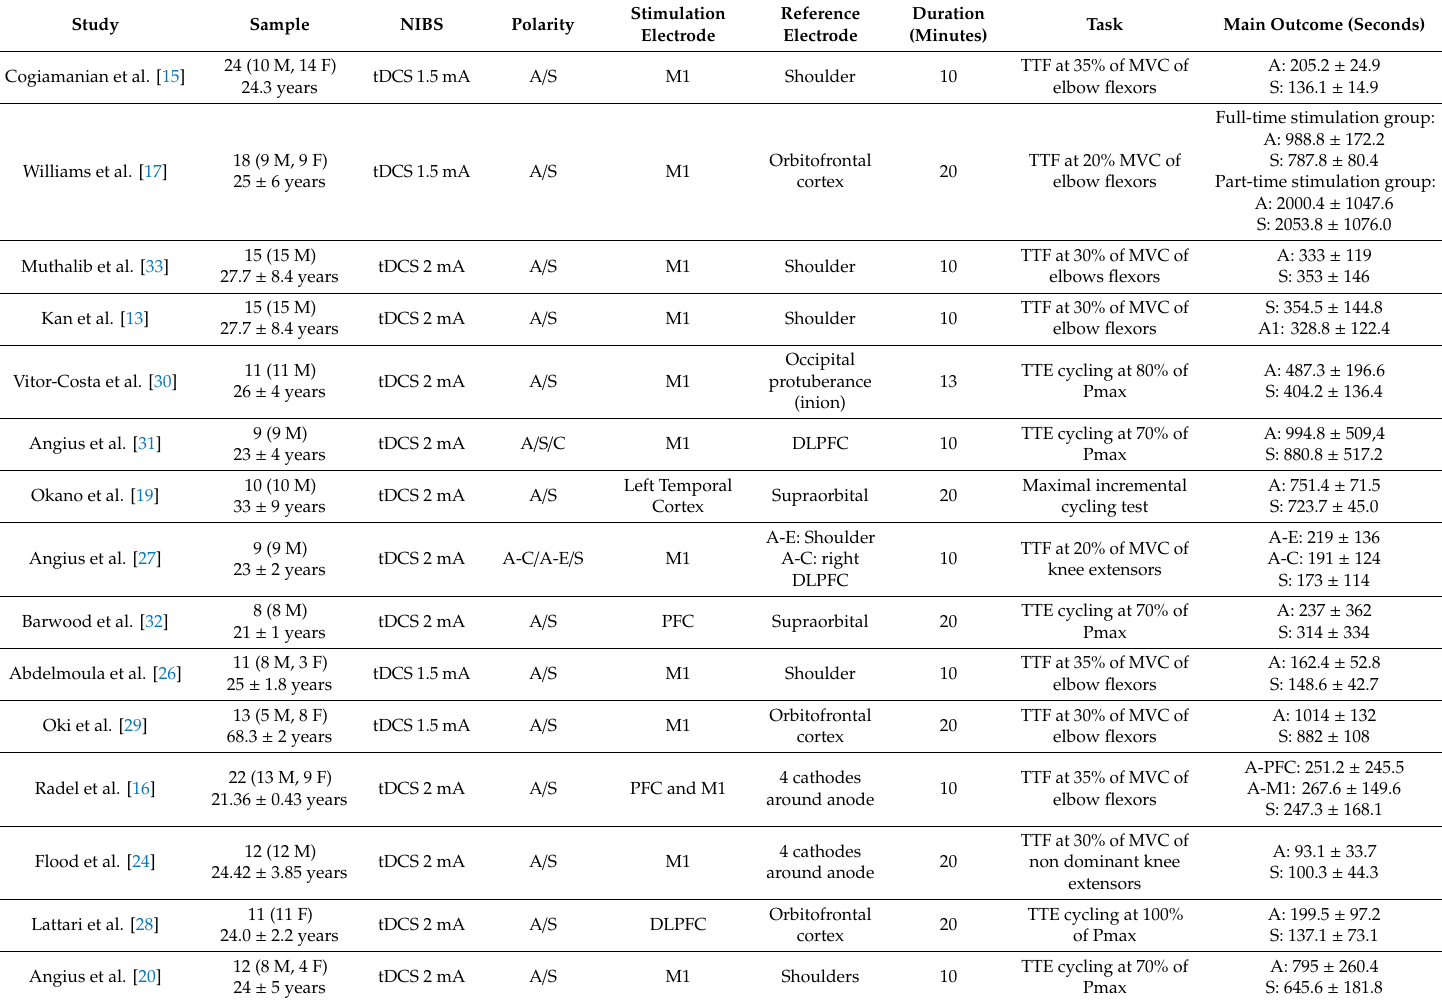
Table 2. Acute e ff ects of TDCS on TTF ( n =